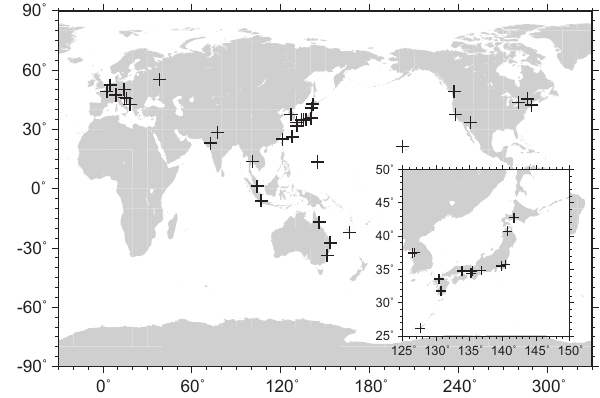
Figure 1. Locations of airports at which CONTRAIL CME ascend- ing and descending observations were collected used in this